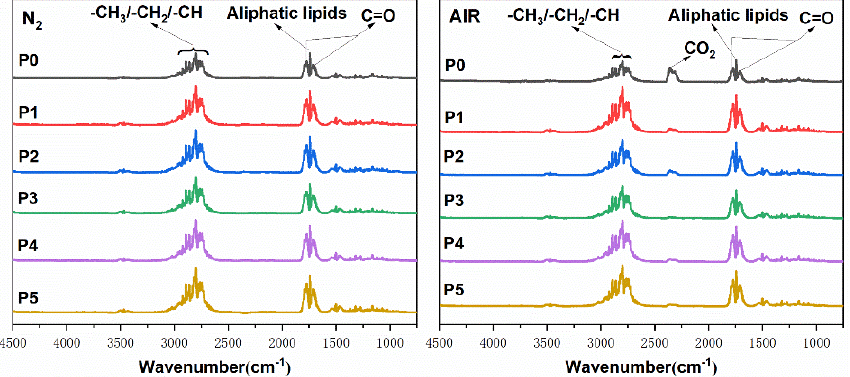
Figure 15. Total decomposition FTIR spectra of FR-POM composites in N 2 and AIR atmospheres, respectively.